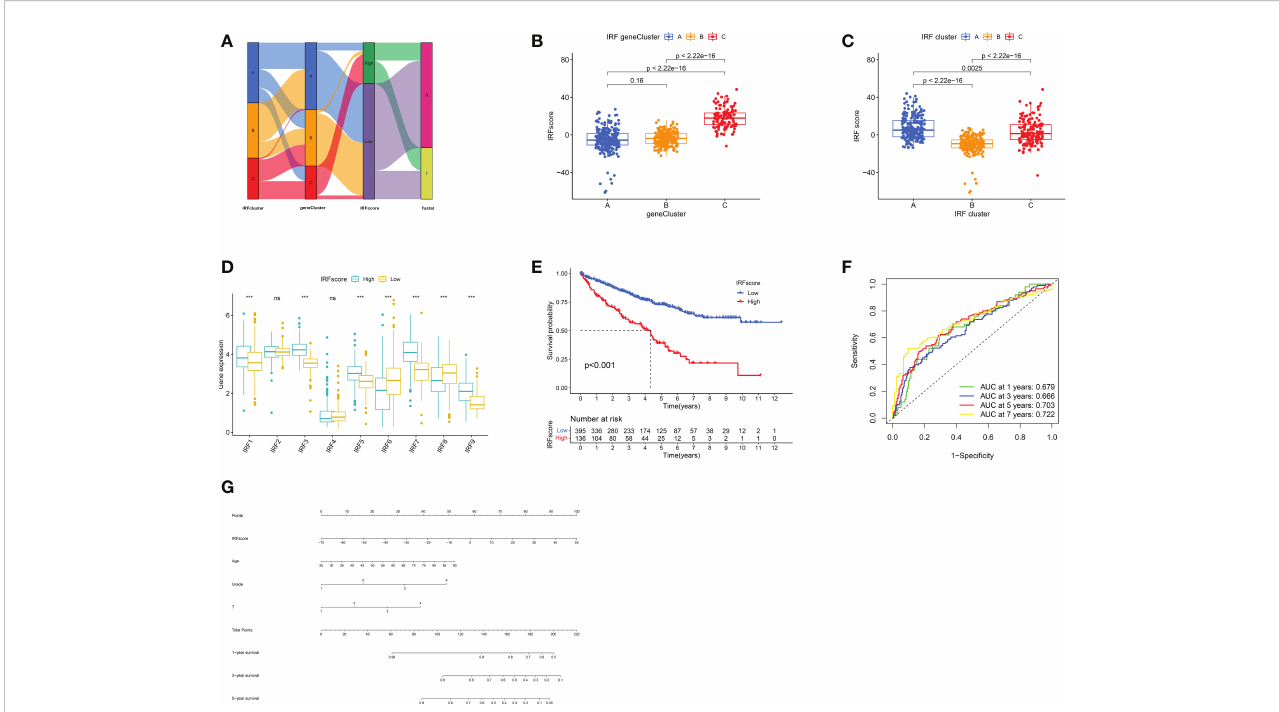
FIGURE 5 Construction of IRF signatures. (A) Alluvial diagram showing the changes of IRF cluster, gene cluster, IRFscore and patient survival status. (B-C) Differences in IRFscore among three gene clusters (B) and IRF clusters (C) . (D) The expression of IRF1-9 in two IRFscore groups. (E) Kaplan-Meier survival analysis for two IRFscore groups. (F) ROCs for 1-, 3-, 5-, and 7-year survival time based on IRFscore. (G) Nomograms incorporating IRFscore and clinical characteristics for predicting patient 1-, 3-, 5-year survival. ns, not signi fi cant; ***p <